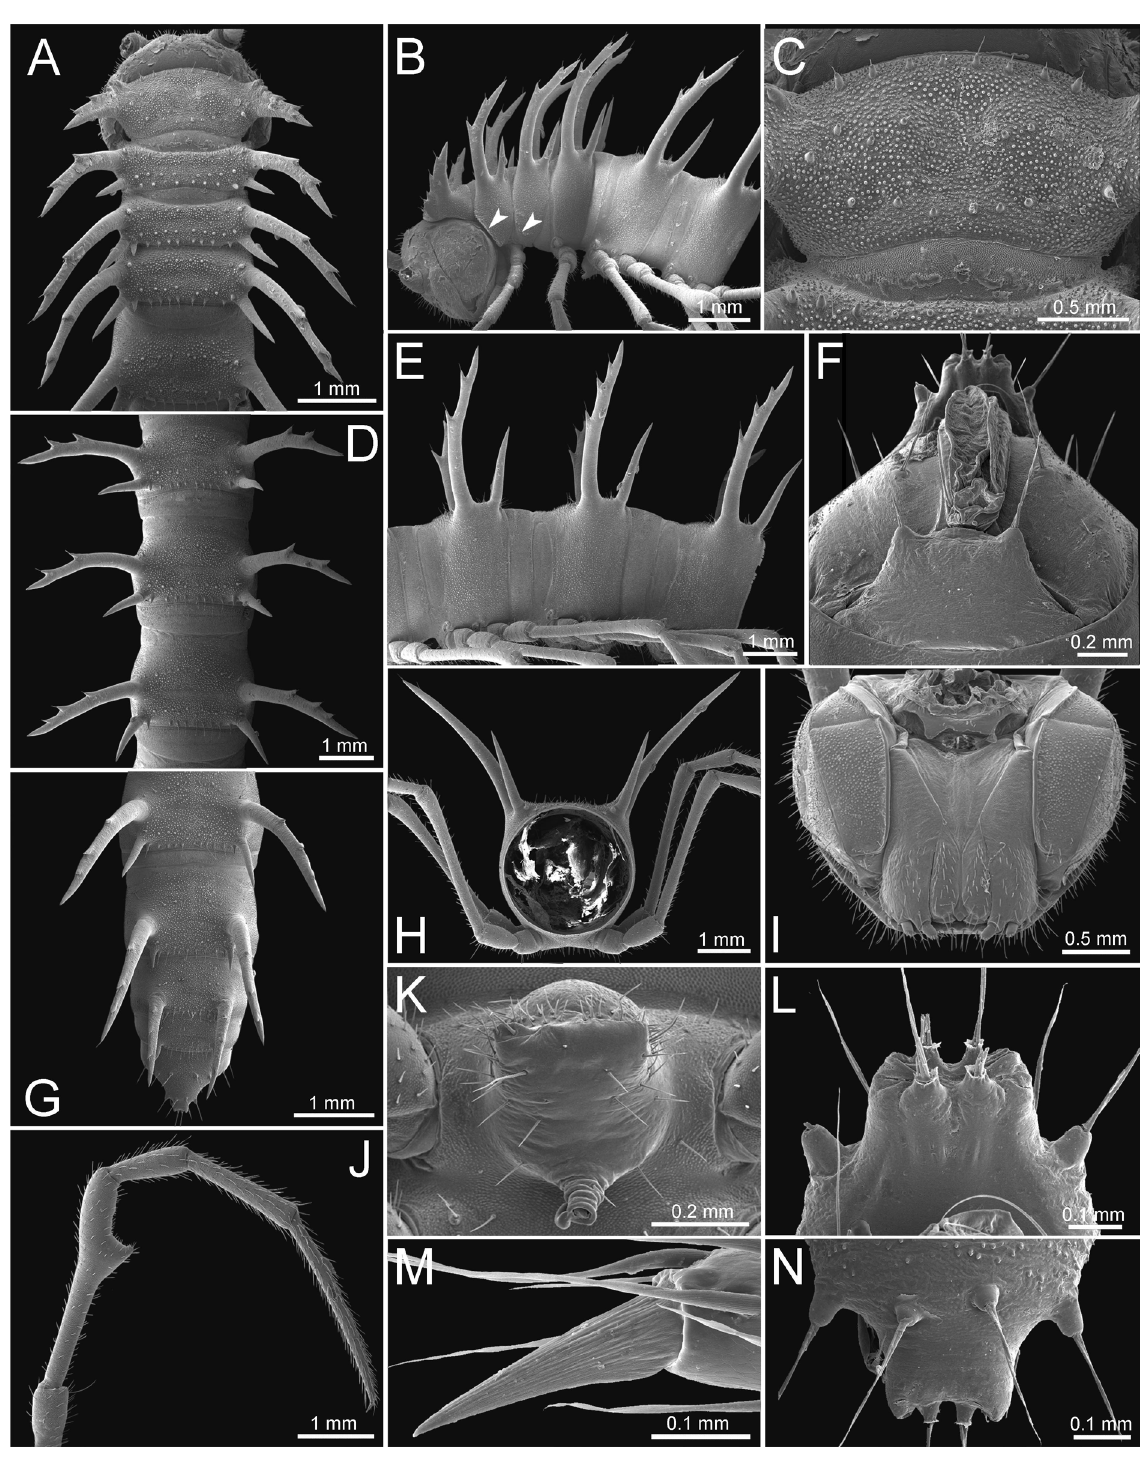
Fig. 2. General body characters of Gigaxytes gen. nov. ( G. fusca Srisonchai, Enghoff & Panha gen. et sp. nov., ♂ paratype) – SEM images. A – B . Anterior body part (arrowheads point to pleurosternal carinae). C . Collum. D . Body rings 9–10. E . Body rings 8–10. F . Telson. G . Posteriormost rings and telson. H . Body ring 10. I . Mouthparts, ventral view. J . ♂ leg 13. K . Sternal lobe between ♂ coxae 4. L , N . Tip of epiproct. M . Tip of tarsus and claw of leg